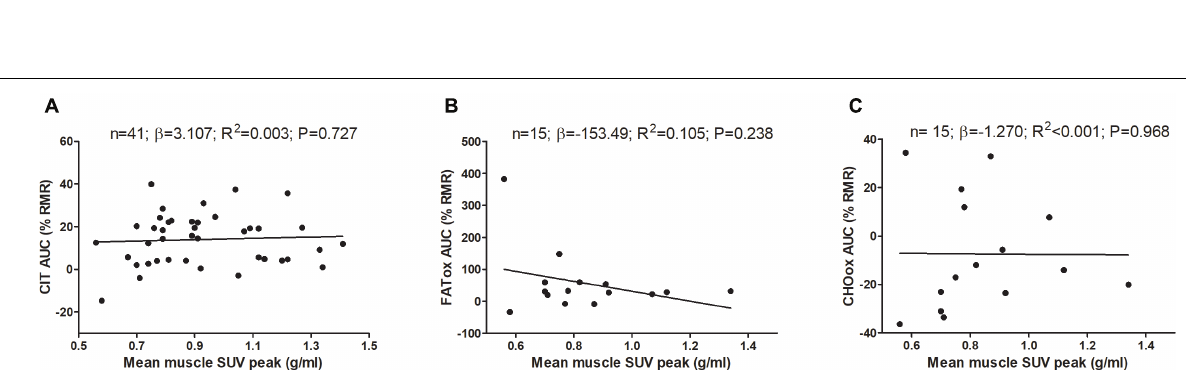
FIGURE 1 | Associations of brown adipose tissue (BAT) 18 F-FDG activity after a personalized cold exposure with cold induced thermogenesis (CIT) and cold-induced nutrient oxidation rates (Study 1). Unstandardized simple regression coefficient ( β ) and standardized coefficient of determination (R 2 ). SUV: Standardized uptake value; AUC: Area under the curve; RMR: Resting metabolic rate; FATox: Fat oxidation rate; CHOox: Carbohydrates oxidation rate.